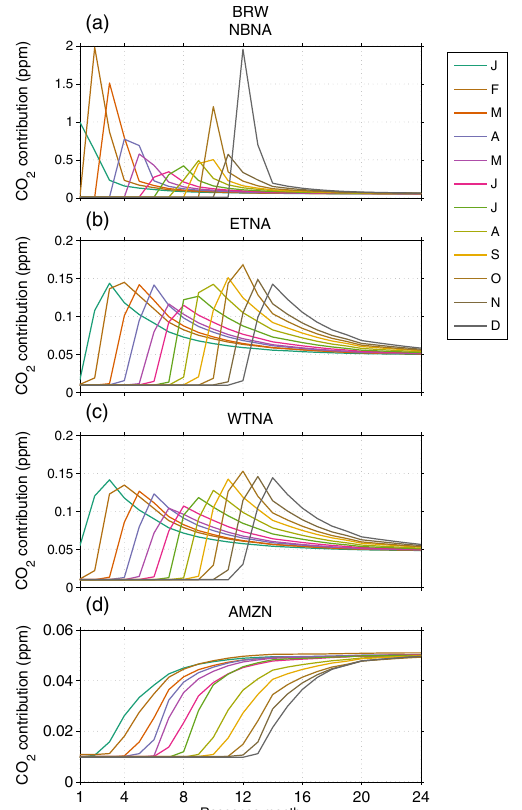
Figure 2. The imprints of 1 PgC pulses emitted in individual months (colored curves) on atmospheric CO 2 at Barrow (BRW). Imprints on the atmosphere sampled at BRW are shown from selected re- gions: (a) northern boreal North America (NBNA), (b) eastern tem- perate North America (ETNA), (c) western temperate North Amer- ica (WTNA), and (d) the Amazon (AMZN). For clarity, we plot only the first calendar year (months 13–24) after the pulses were